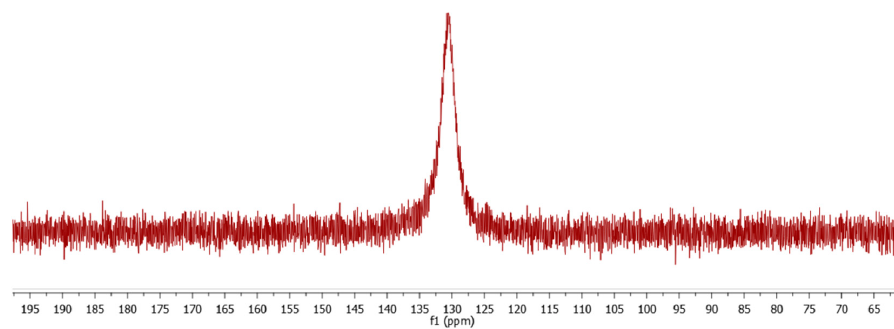
◦ C. 3 ) of compound 2 at 25